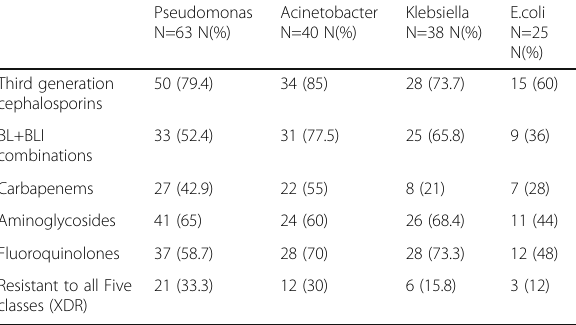
Table 1 (abstract 0179). RESISTANCE PATTERN OF THE MOST COMMON ORGANISMS Pseudomonas N=63 N(%)